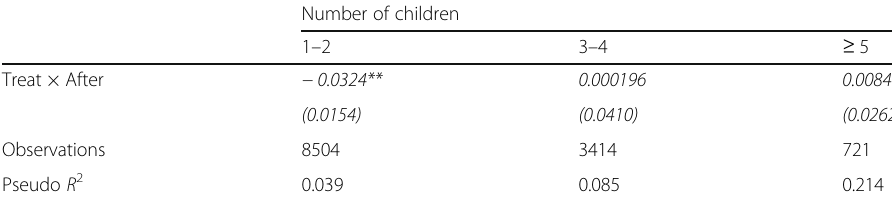
Table 8 Effect of AUH on the probability of entering the labor force. Heterogeneities: number of children Number of children Treat × After −